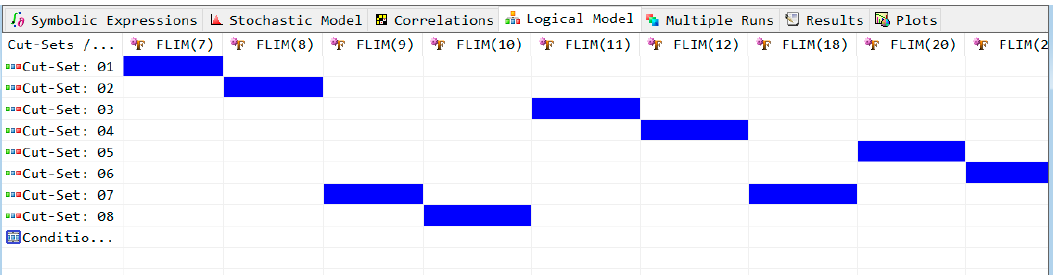
Figure 6. Logical model in the SYSREL program.